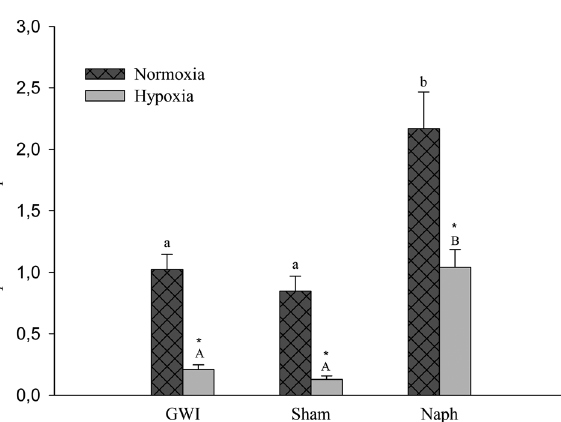
Figure 5 - Relative tp53 gene expression in C. macropomum liver in the the three experimental groups: Group Without Injection (GWI); Group with corn oil injection (Sham); and Group with naphthalene injection (Naph) after 96 h normoxia exposure followed by 6 h of hypoxia. Small cap letters (a and b) indicate differences among treatments in normoxia. Capital letters (A and B) indicate differences among treatments in hypoxia. *Indicates differences between normoxia and hypoxia of the same treatment ( p